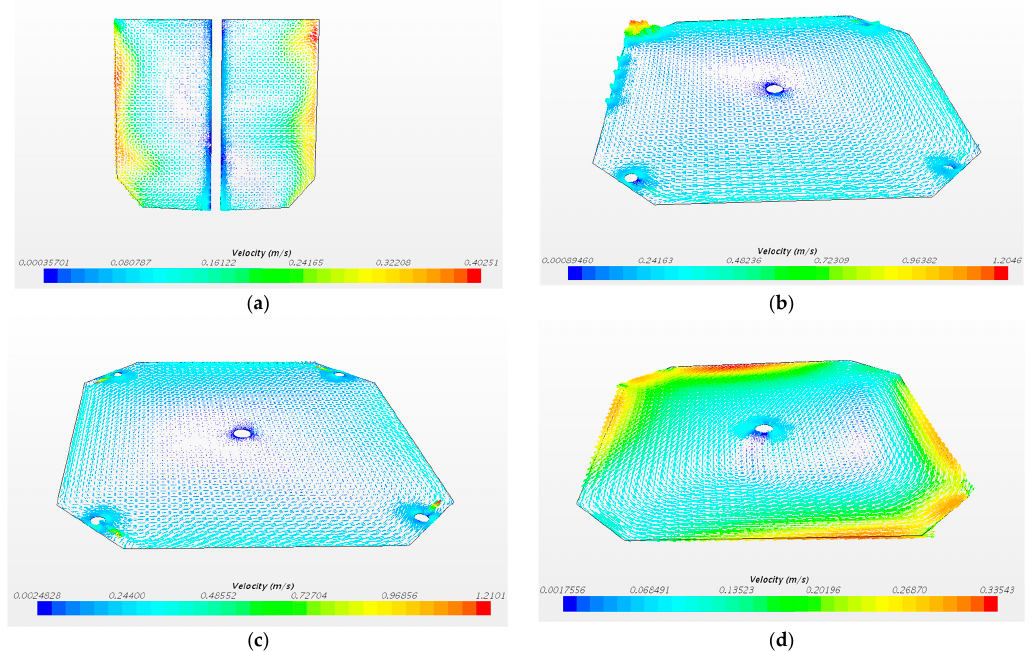
Figure 6. ( a ) middle longitudinal section, ( b ) H = 16.5 m cross section, ( c ) H = 8.5 m cross section, ( d ) H = 1.5 m cross section.